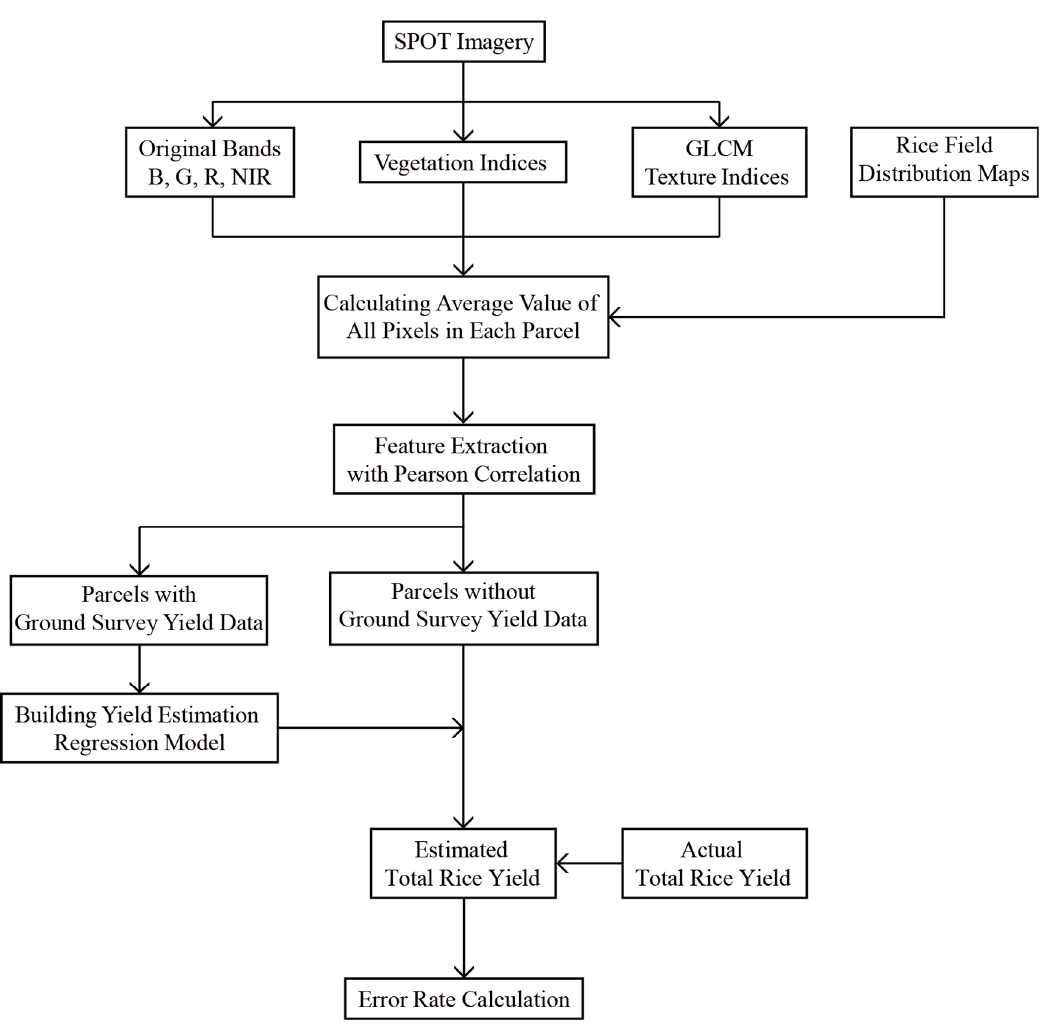
Figure 4. Flow chart of rice yield estimation. B—blue; R—red; G—green; NIR—near-infrared; GLCM—grey-level co-occurrence matrix.